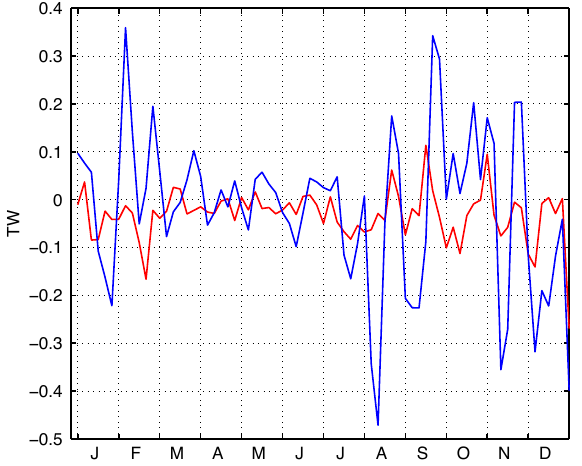
Fig. 4. Estimates of the heat flux error (in TW) due to neglecting short term fluctuations (blue – Eq. A6) compared with, in red, the difference between the actual change in model heat content and that estimated from the 5-day mean